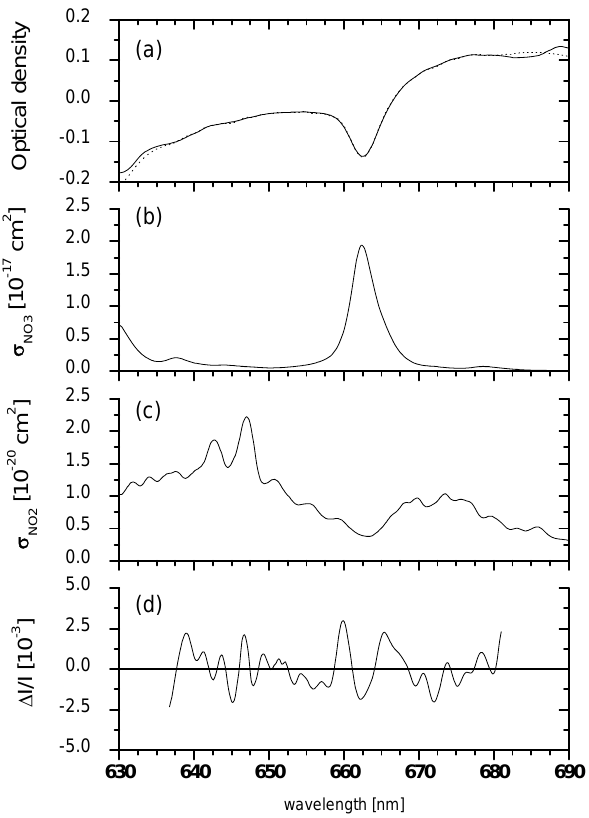
Figure 6. CE-DOAS spectra of 631 pptv NO3 with traces of NO2, O3 and H2O. Panel (a) shows the measured spectrum smoothen with a low pass filter (solid line) and overlaid by the fit result (dotted line). Panel (d) shows the residual spectrum in the data region relevant for the fit. Panel (b) and (c) show the absorption cross sections from NO 3 and NO 2 , respectively.